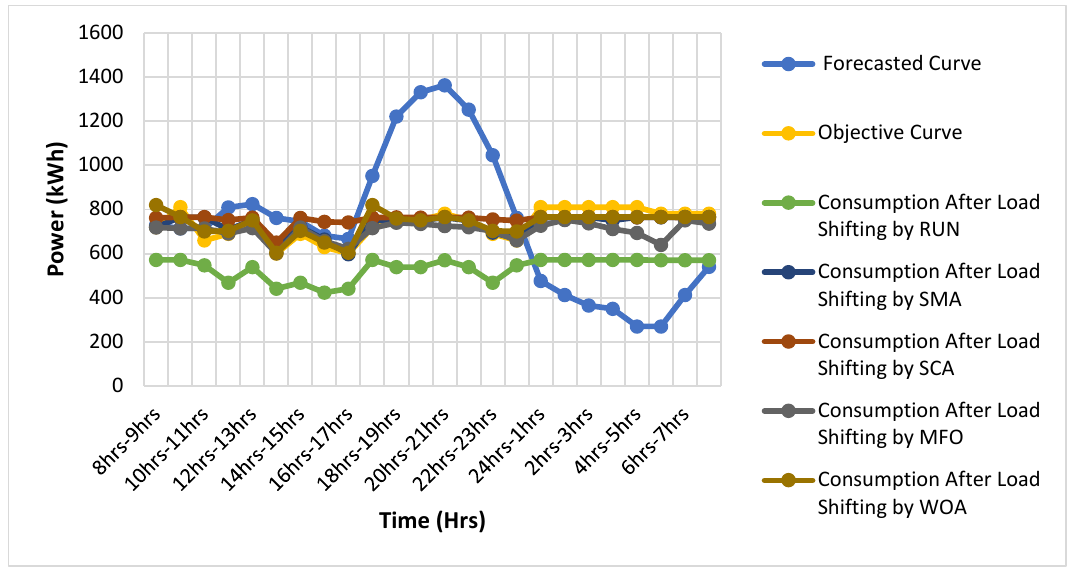
Figure 11. Load shifting results for residential consumers. Figure 12 reported the simulation results for the commercial area by load shifting. Table 5. Operational cost and peak demand reduction due to load For residential and commercial areas, the peak demand is given by Table 5. For the resi- dential area, the used DSM technique lowered the peak load by using the SMA, SCA, MFO, and WOA which is given by 44.02%, 43.89%, 46.79%, and 43.89%, respectively. The RUN again gives better results by a 58.26% reduction. For the commercial area, the used DSM technique lowered the peak load by using the SMA, SCA, MFO, and WOA which is given by 15.85%, 15.85%, 18.53%, and 15.92%, respectively. The RUN again gives better results by a 30.97% reduction.